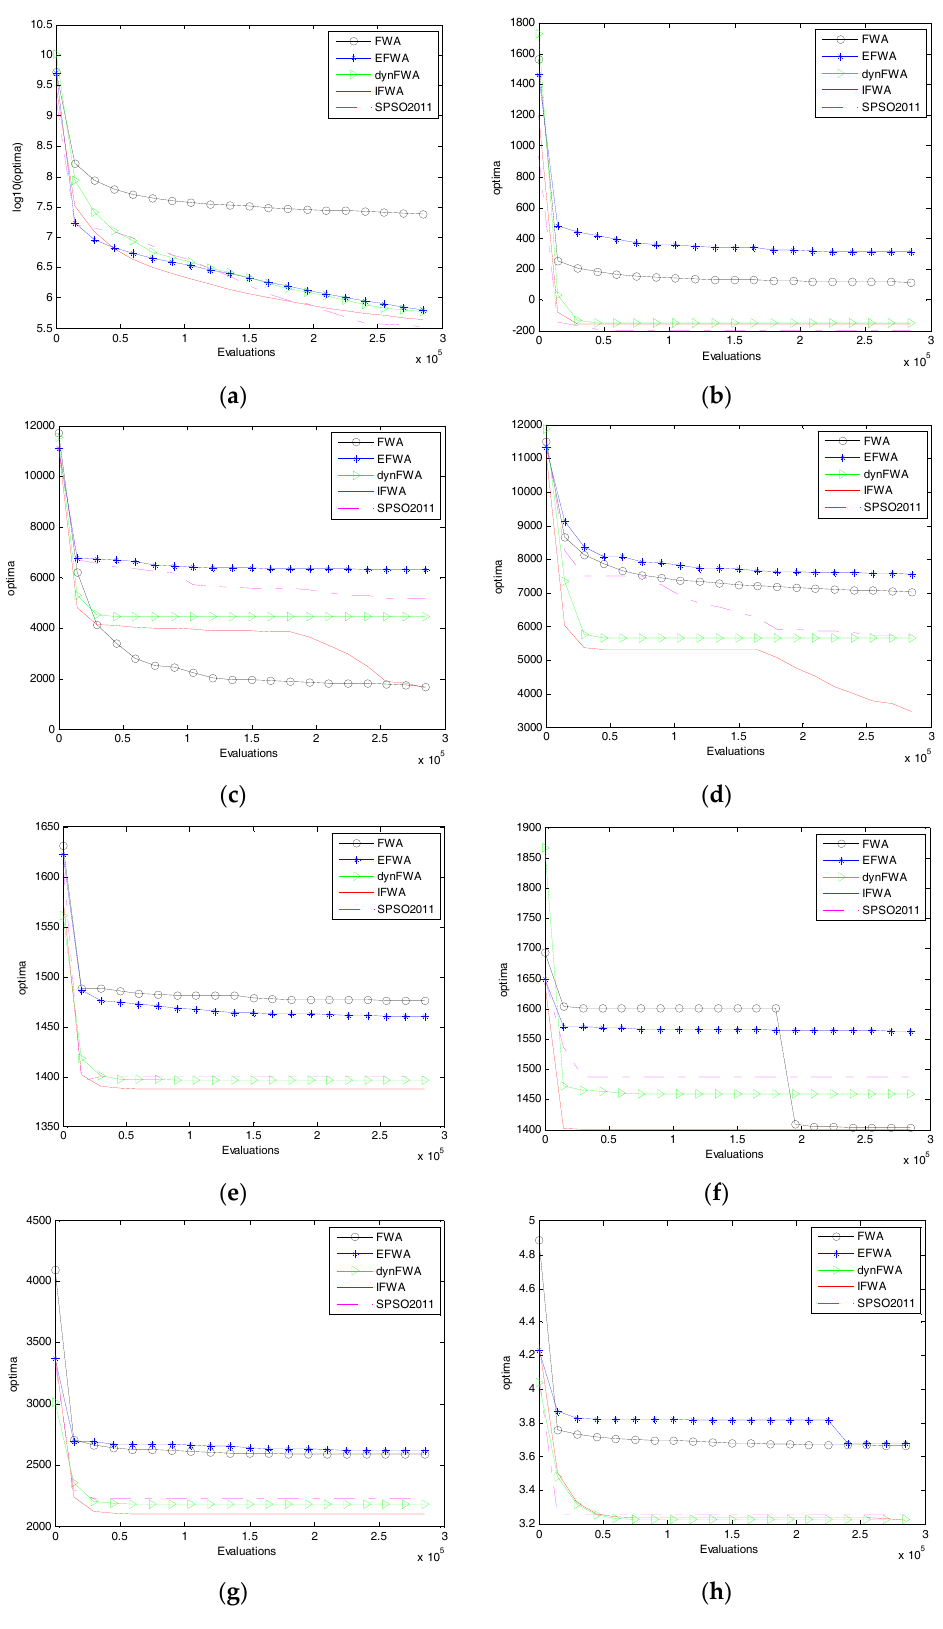
Figure 2. The FWA, EFWA, dynFWA, SPSO2011 and IFWA searching curves. ( a ) f2 function; ( b ) f12 function; ( c ) f22 function; ( d ) f23 function; ( e ) f25 function; ( f ) f26 function; ( g ) f27 function; ( h ) f28 function.